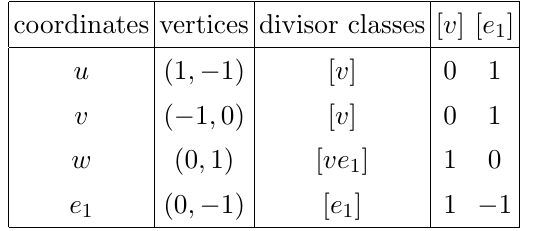
Table 1 . Coordinates, vertices, divisor classes and intersection numbers (charges of C (cid:3) -actions) for the two-dimensional toric variety dP 1